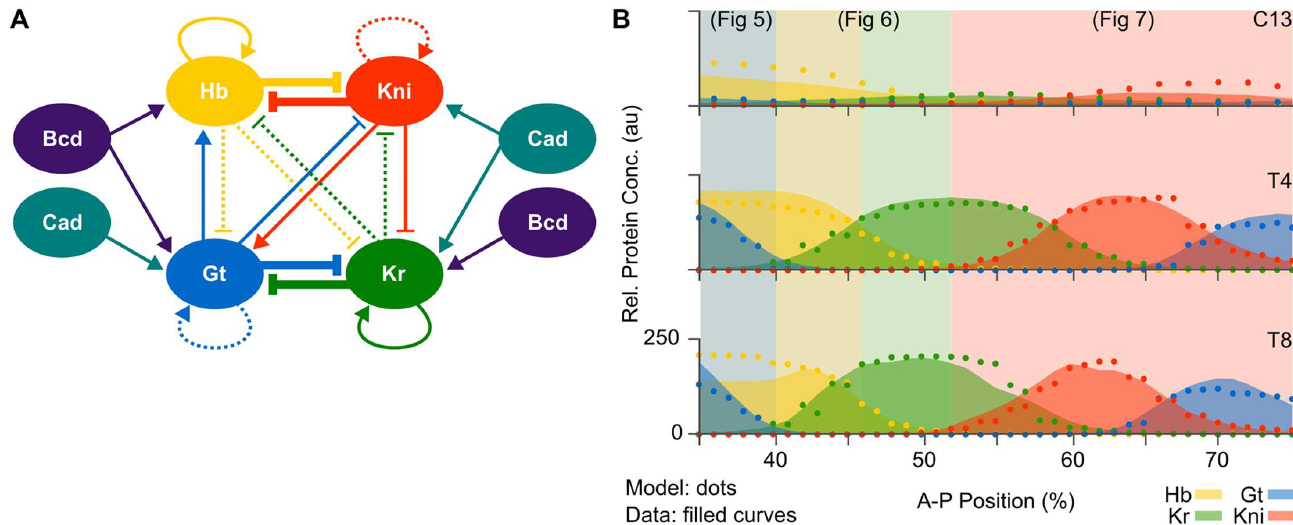
Fig 3. Non-autonomous gap gene circuits. (A) Regulatory structure derived from previously published non-autonomous gap gene circuits with diffusion[26]. Connectingarrows and T-bars represent activatingand repressiveinteractions, respectively.Line thickness indicatesan interaction’s relative strength, with very weak interactions dashed. (B) Model output of a fully non-autonomous gene circuit without diffusion(dots) and gap protein data (filled curves) at three time points: C13 (early), T4 (mid), and T8 (late blastodermstage). The x-axis represents %A–P position,where 0% is the anterior pole. The y-axis represents relative protein concentration in arbitrary units (au). Colouredbackground areas indicatedifferent dynamic patterningmechanisms that are shown in detail in Figs 5–7.